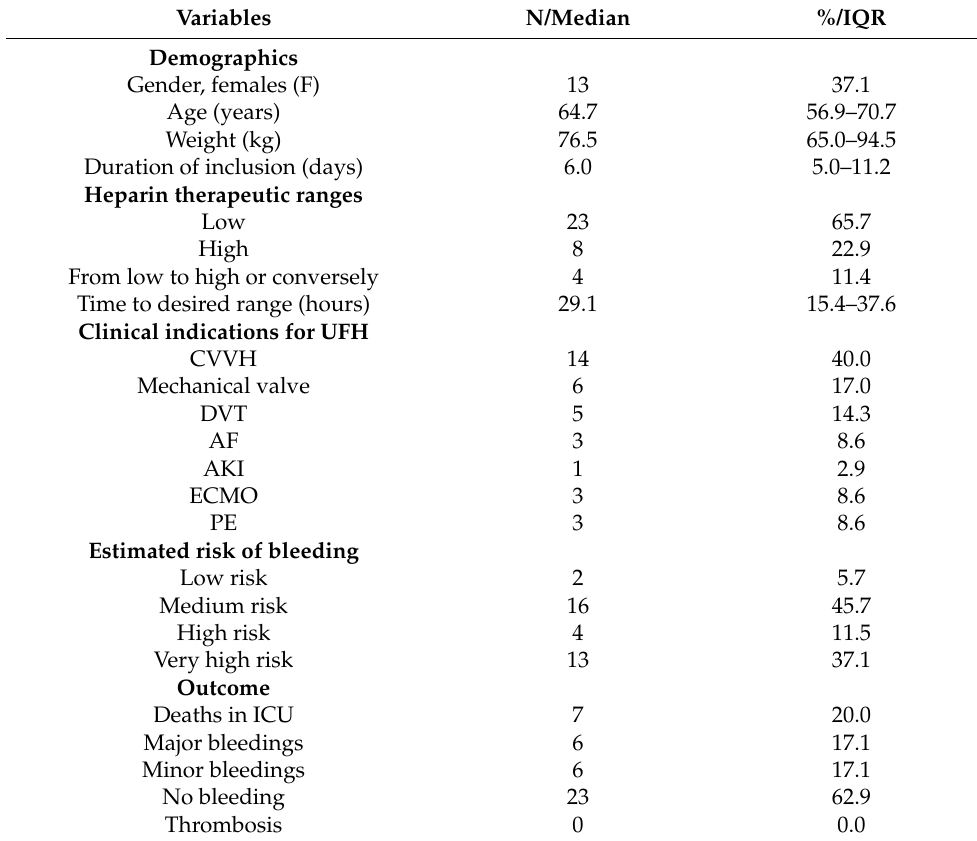
Figure 1. Flow diagram of identification, eligibility and inclusion processes. The basal POCT is the first POCT obtained before starting UFH administration. COVID, coronavirus disease 2019; POCT, point of care test; UFH, unfractionated heparin. Table 3. Characteristics of the 35 patients